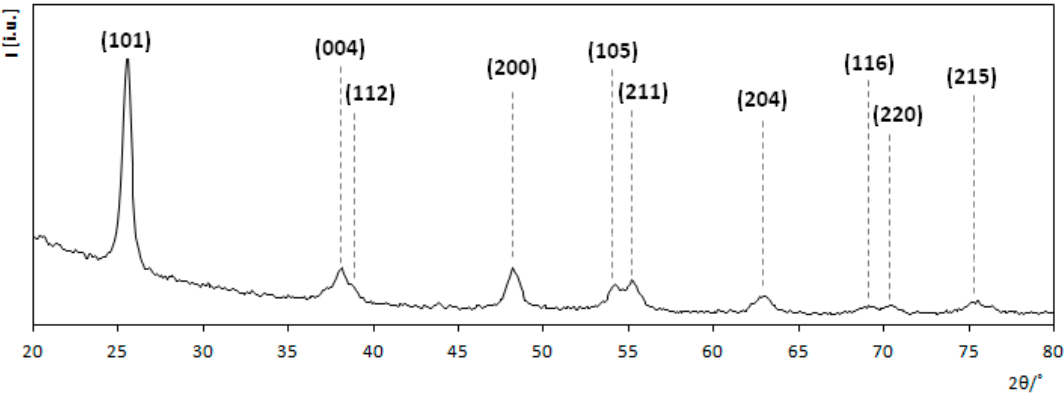
Figure 2. X-ray di ff raction pattern of bare TiO 2 coating. Figure 2. X-ray diffraction pattern of bare TiO 2 coating . Figure 2. X-ray diffraction pattern of bare TiO 2 coating .